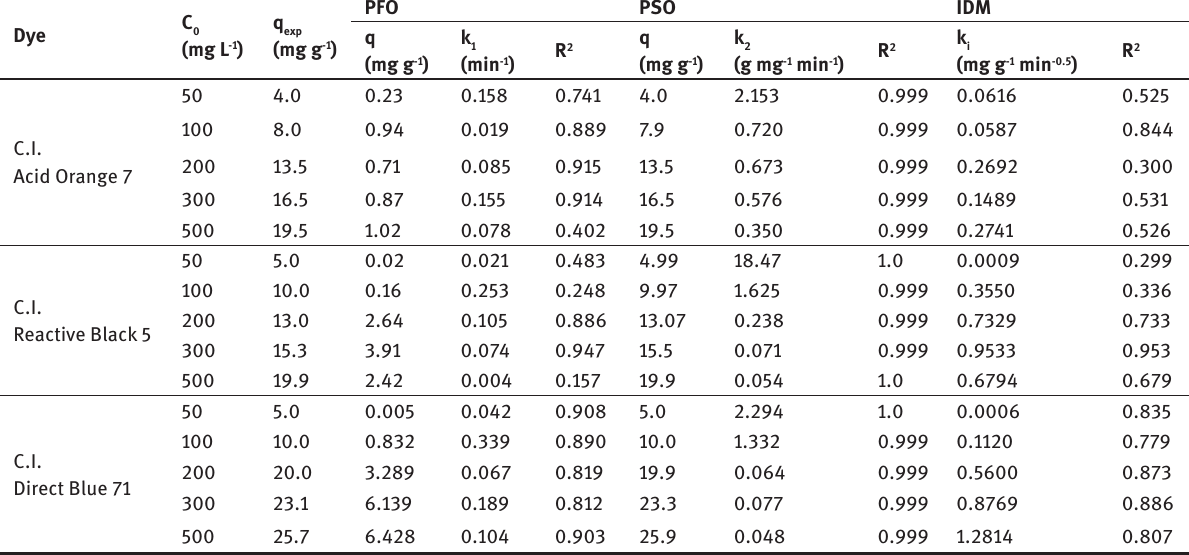
Table 3: Comparison of kinetic data for the acid, reactive and direct dyes sorption on the aminosilane modified silica.